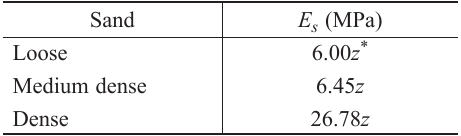
Table 6. Adjusted E s profile for each sand density Sand E s (MPa) Loose 6.00 z * Medium dense 6.45 z Dense 26.78 z * z is depth from sand surface in meters